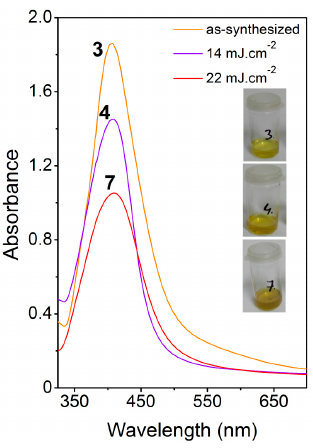
Figure 2. Absorption spectra of colloid solutions of electrochemically synthesized AgNPs in ultraviolet-visible region. As-synthesized solution (yellow curve-3), AgNPs colloid after laser irradiation at fluence 14 mJ cm − 2 (purple curve-4), AgNPs colloid after laser irradiation at fluence 22 mJ cm -2 (red curve-4). Insets to the left show photographs of corresponding colloids.